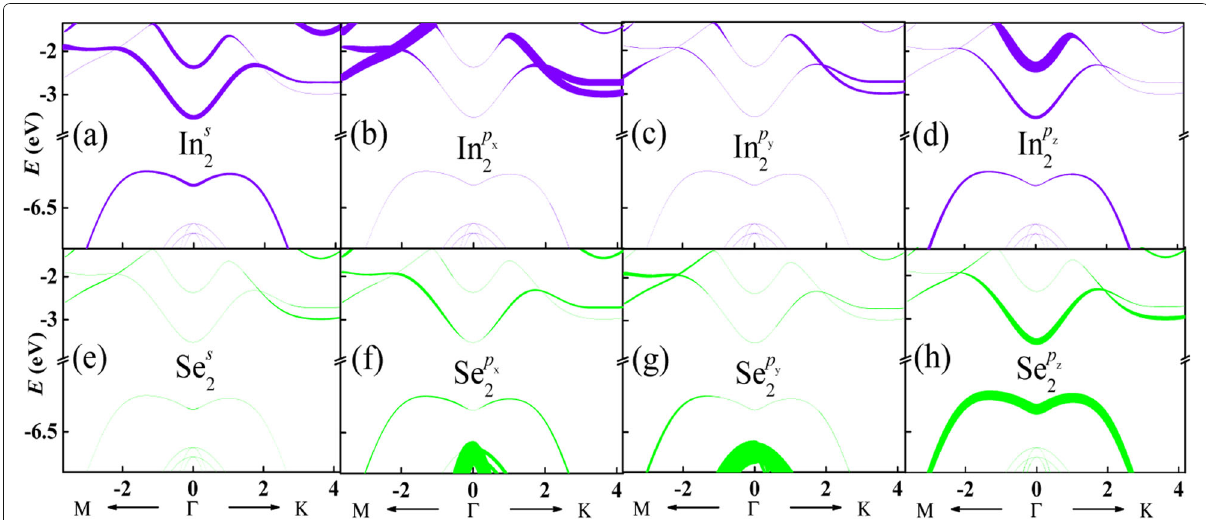
Fig. 2 (Color online) Orbital decompositions for the energy band of monolayer InSe. Thicker lines indicate a more dominant contribution. Only In and Se ions in sublayer 2 are selected as examples since the two sublayers of the monolayer InSe with mirror symmetry along z -axis ( a – h )